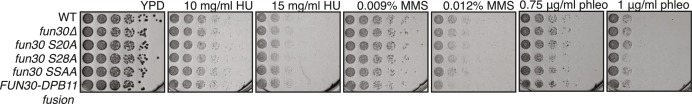
Mutants of Fun30 show no discernable phenotype upon chronic exposure to HU, MMS or phleomycin.Spotting in 5-fold serial dilutions on medium containing indicated dosages of DNA damaging agents. Plates were incubated two days at 30°C.